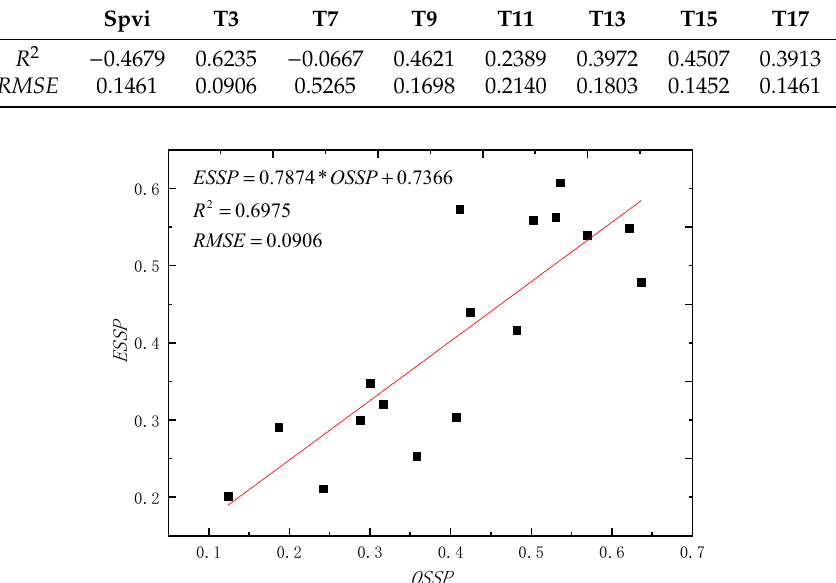
Table 7. Accuracy of spatial structure parameter estimation with different feature factor subsets.